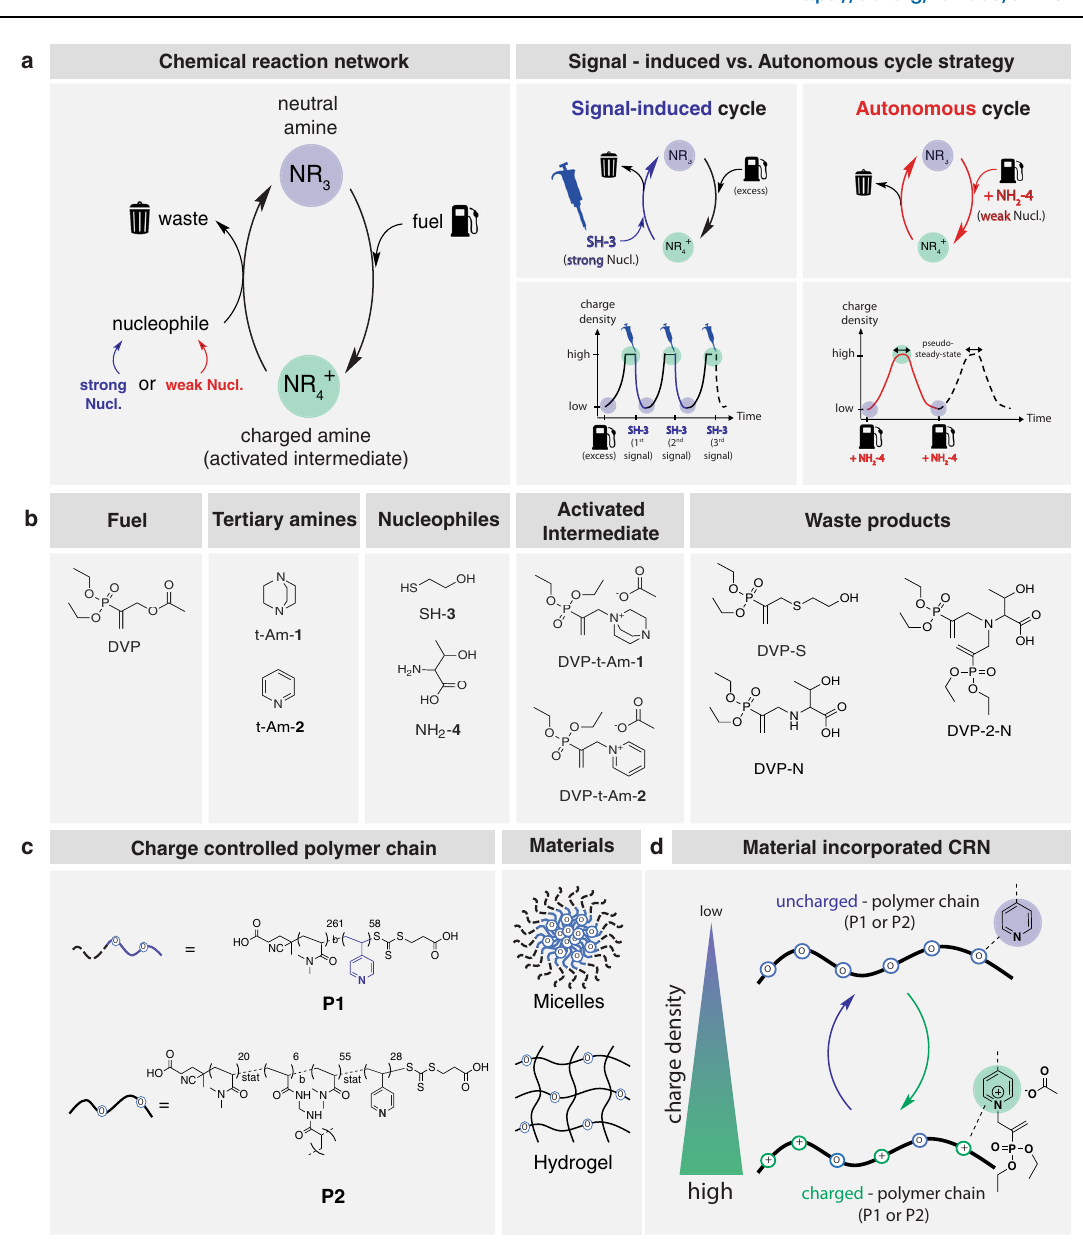
polyamine-functionalized polymer chains using our CRN strategy and charge density distribution. Speci fi cally, fuelled tertiary amines generate charged qua- ternary nitrogens (activated intermediate), which in turn creates hydrophilic domains along the polymer backbone. A secondary nucleophilic substitution results in the regeneration of the uncharged polyamine by substitution of the intermediate (deactivation) towards the waste